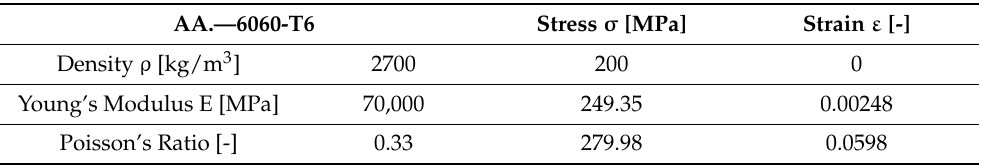
Table 1. Material properties of aluminum (own research).